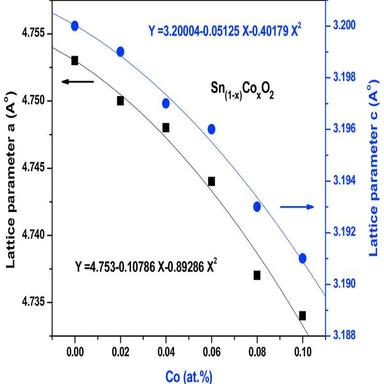
Lattice parameters a¨and ¨ ¨cof¨ Tetragonal polycrystalline as a function of SnO2 nanoparticles doped with Co.